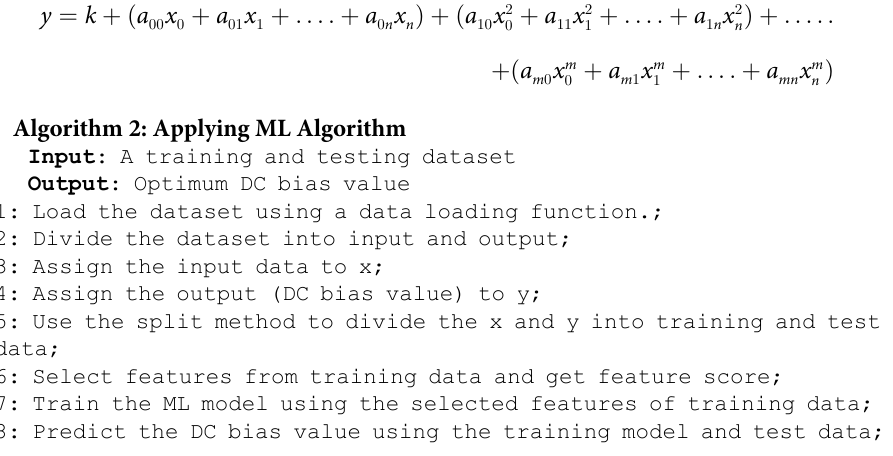
Algorithm 2: Applying ML